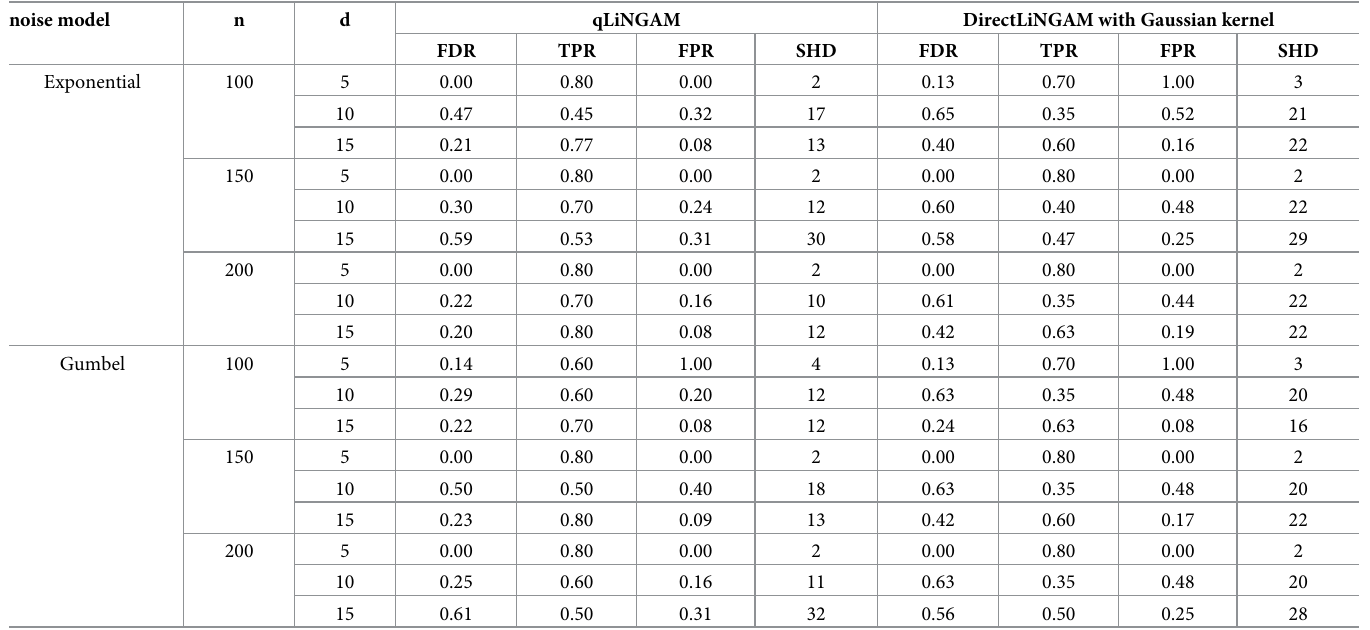
Table 1. Comparison of the accuracy of qLiNGAM and DirectLiNGAM with Gaussian kernel using the artificial data from the Erdos-Reny graph. noise model n d qLiNGAM Exponential